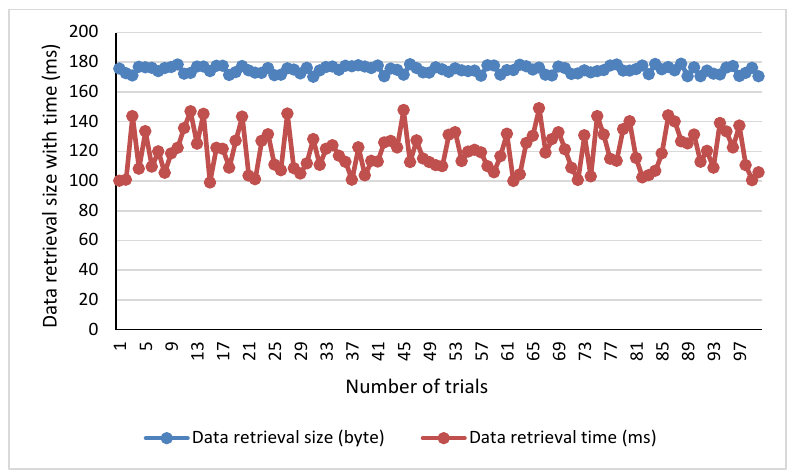
Figure 11. Data retrieval size (bytes) with time against the number of trials.